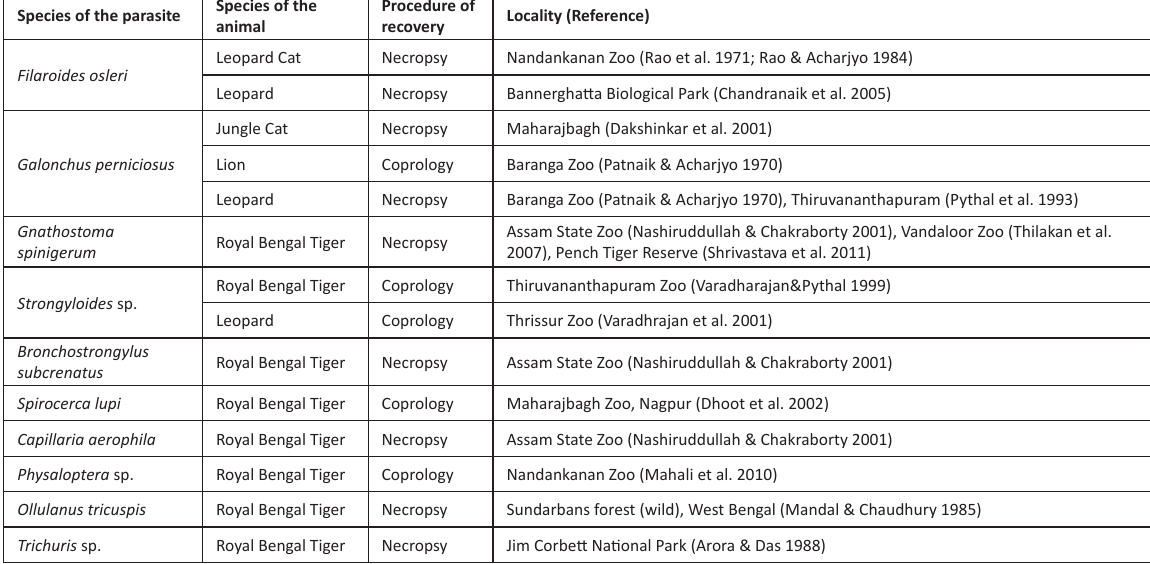
Table 5. Reports of various nematode parasitic infections in wild felids Species of the Species of the parasite animal